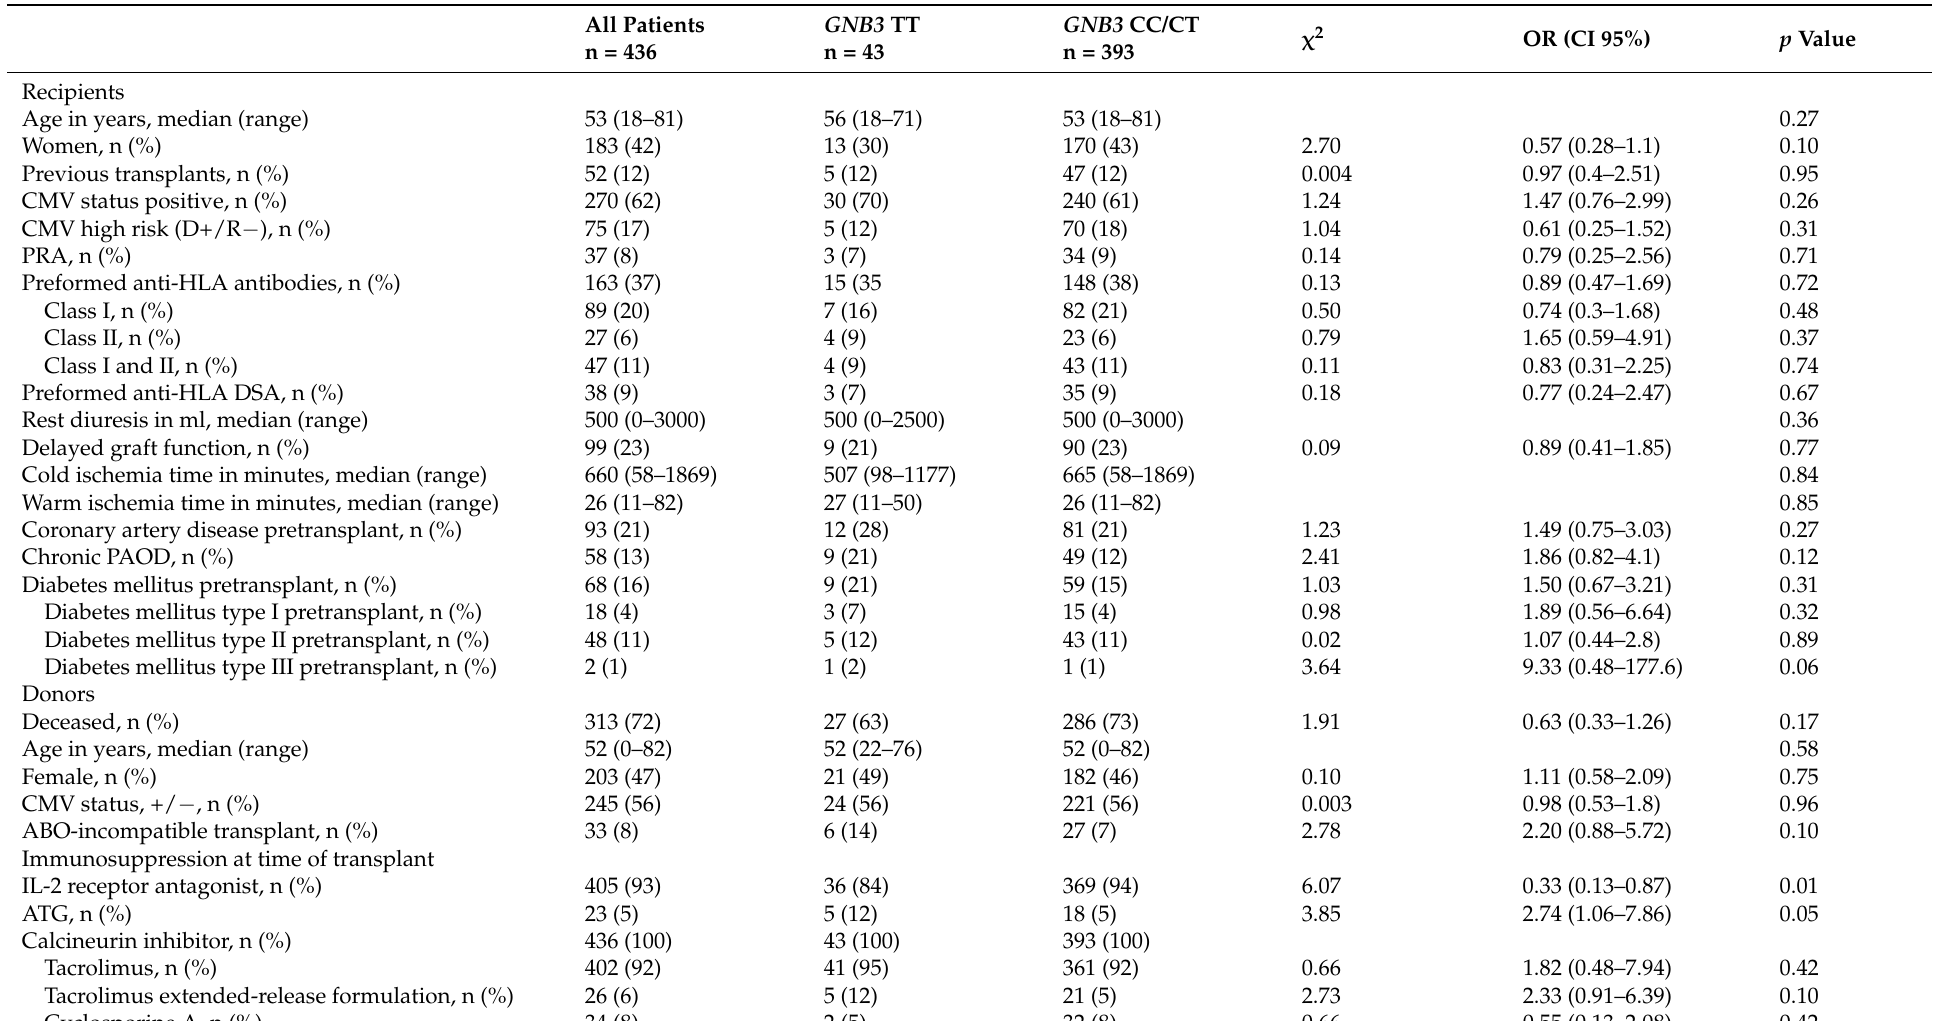
Table 1. Baseline characteristics of 436 renal allograft